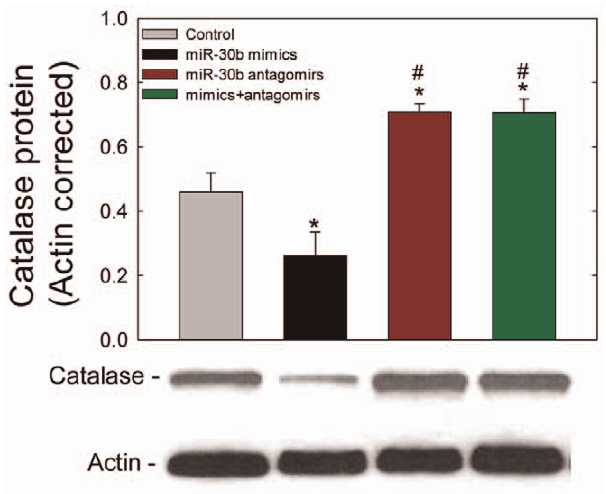
Figure 6. Effects of miR-30b mimics and antagomirs on catalase protein expression in ARPE-19 cells. Cells transfected for 24 h with NC, miR-30b mimics, or miR-30b antagomirs, were lysed and subjected to western blotting following the protocol mentioned in ‘Materials and Methods’. The PVDF membrane was immunoblotted with anti-catalase and anti- m -actin antibodies. b -Actin was used as a loading control. Data reported here are representative of the experiment performed in triplicate. The ratio of band intensity is relative to that of b -actin. The band intensity was measured by using ImageJ software (see ‘Materials and Methods’). Values are presented as mean 6 SEM; n=3. * p , 0.05 vs. control, # p , 0.05 vs. miR-30b mimics.